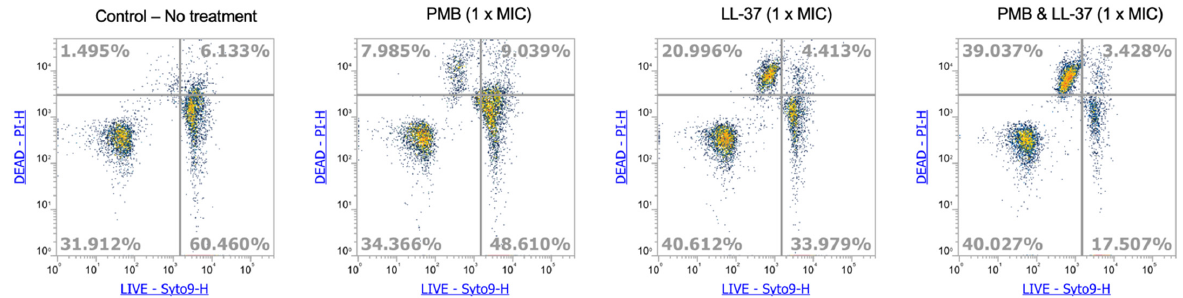
Figure 8. Membrane disruption of E. coli MG1655 by PMB and LL-37, alone and in combination. Cells of E. coli MG1655 were incubated for 30 min in the presence of MIC concentrations of PMB, LL-37 and PMB + LL-37. Cells were subsequently stained with Syto 9 and propidium iodide for 15 min in the dark. Fluorescence was measured using an ATTUNE NXT Flow Cytometer (Thermo the dark. Fluorescence was measured using an ATTUNE NXT Flow Cytometer (Thermo Fisher) until Fisher) until 15,000 events were obtained. Results were analyzed using the Flow Cytometer Soft- 15,000 events were obtained. Results were analyzed using the Flow Cytometer ware.